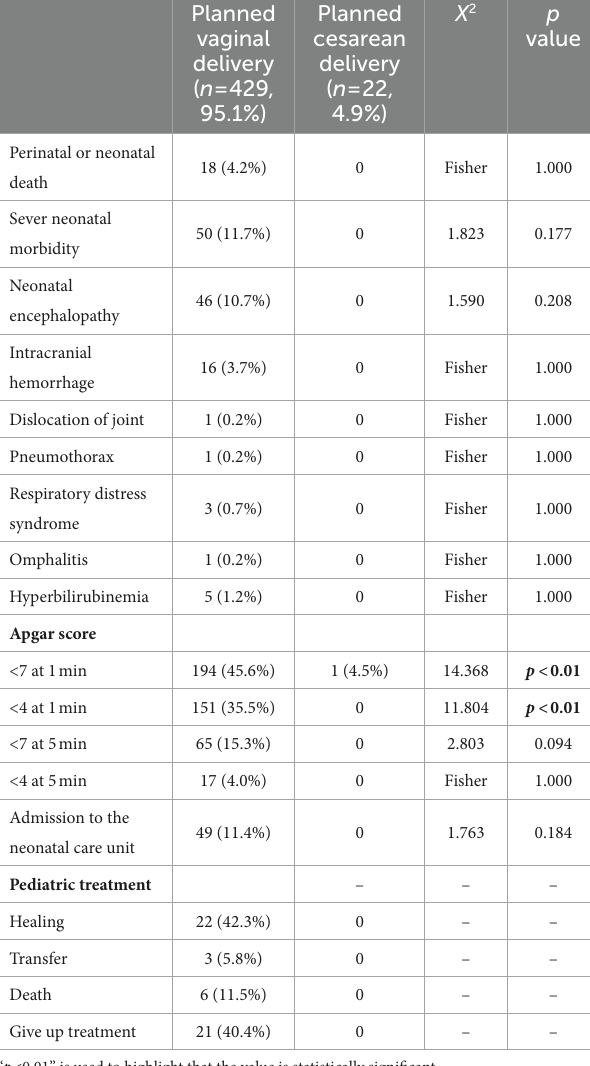
TABLE 3 Primary outcome of term infants in breech presentation between planned vaginal delivery and cesarean